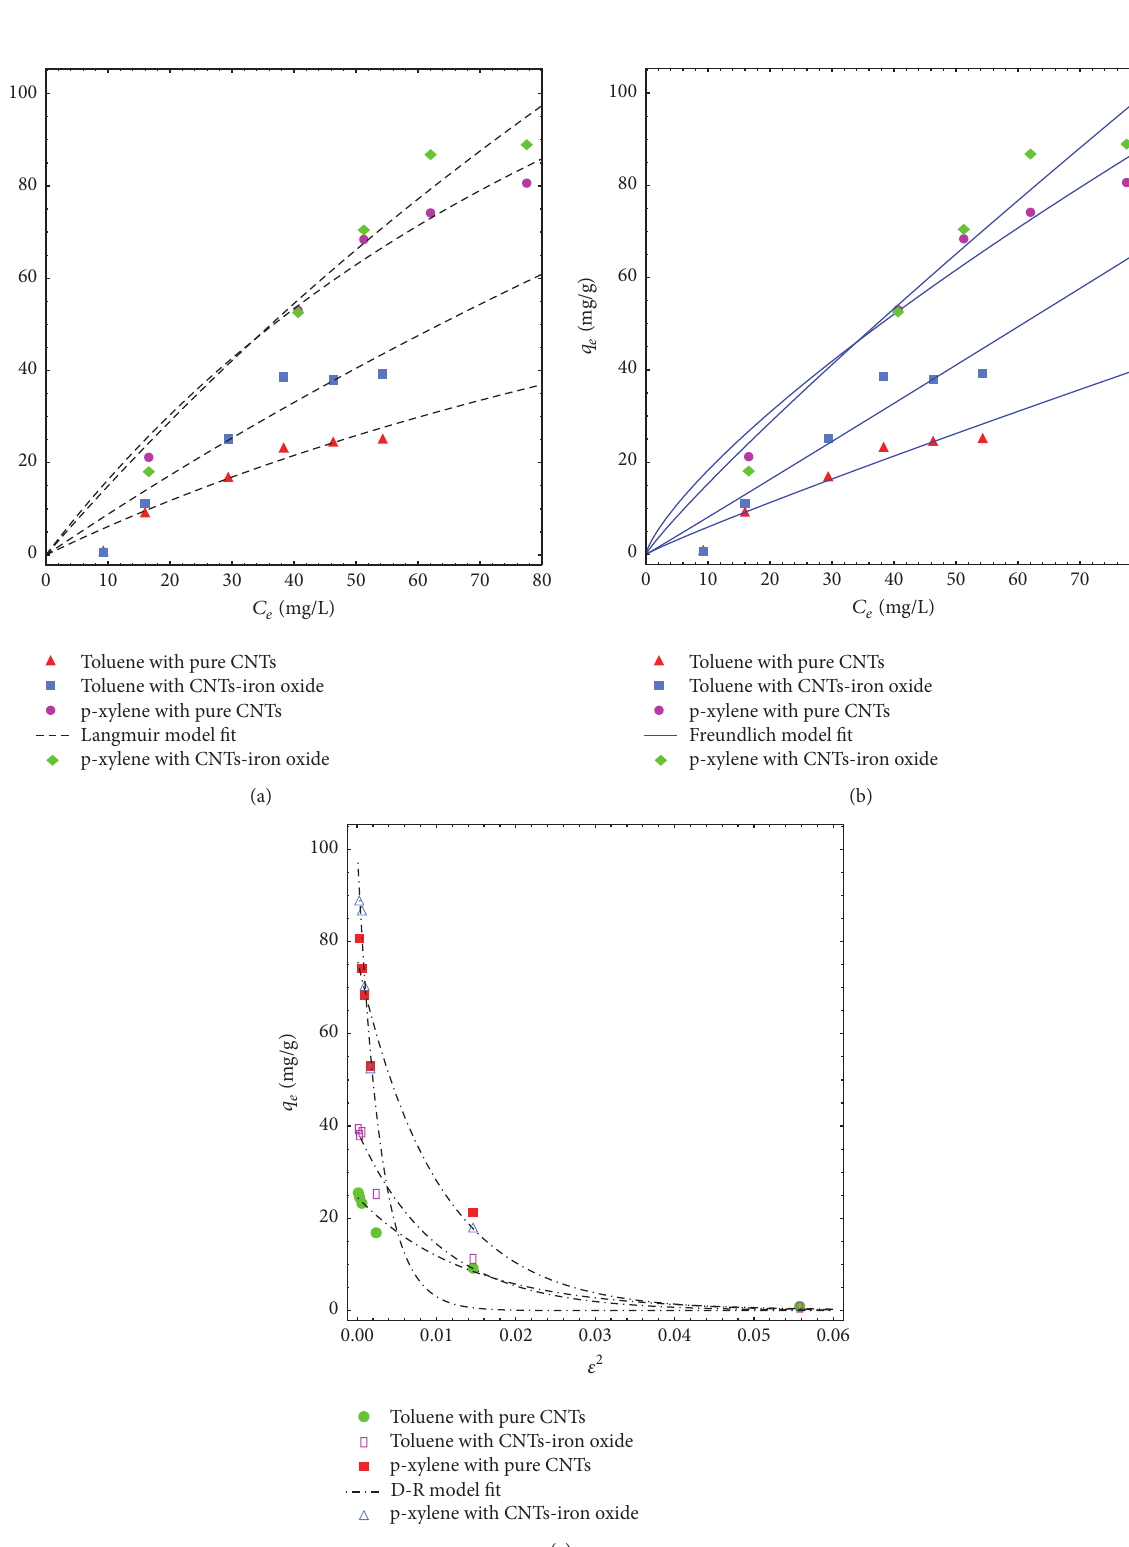
Figure 10: Adsorption isotherm model fitting using (a) Langmuir, (b) Freundlich, and (c) D-R model for toluene and